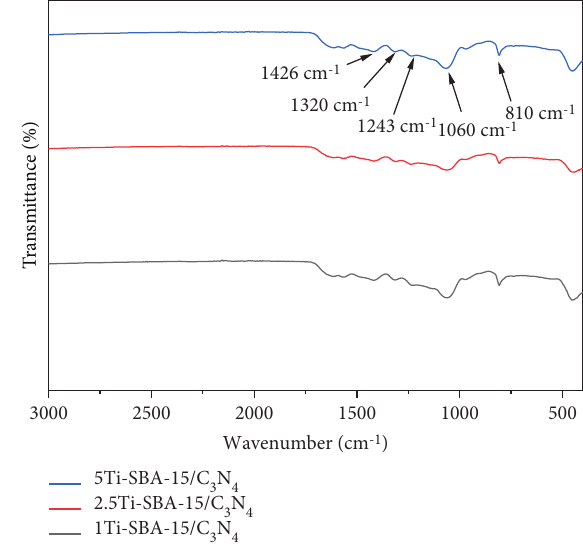
3 N 4 and xTi-SBA-